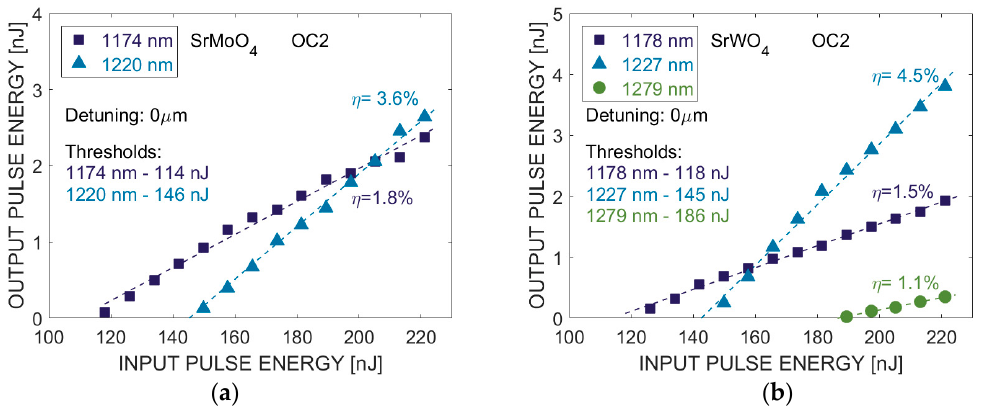
Figure 7. Dependences of the output SRS pulse energy on the input pump pulse energy in the ( a ) SrMoO 4 [88] and ( b ) SrWO 4 Raman lasers at the output coupler OC2 for the case of perfect synchronization.